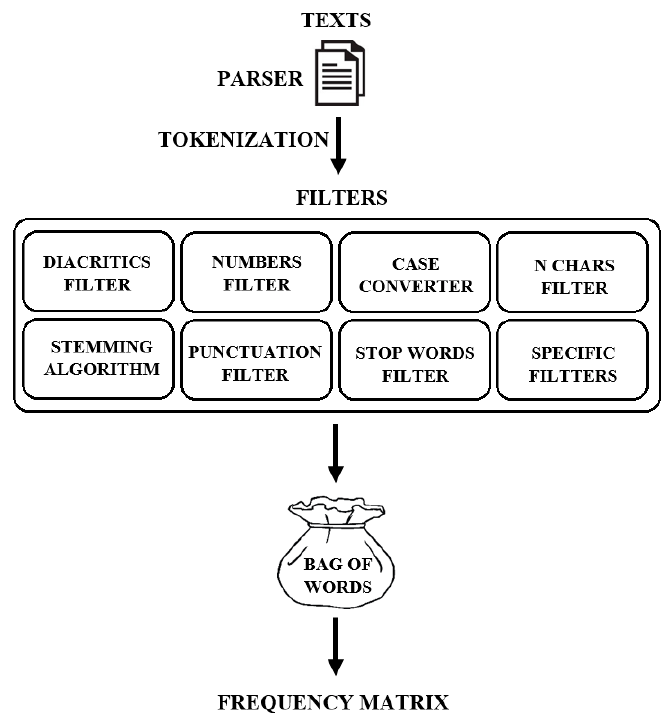
Figure 1. The scheme of the proposed approach; SOM: self-organizing maps.